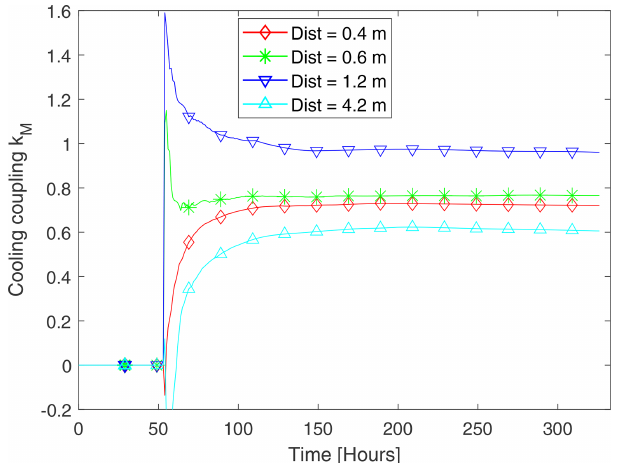
Figure 8. Change of heat production during ripening, estimated by the Ripening model; same pallet positions as in Fig.